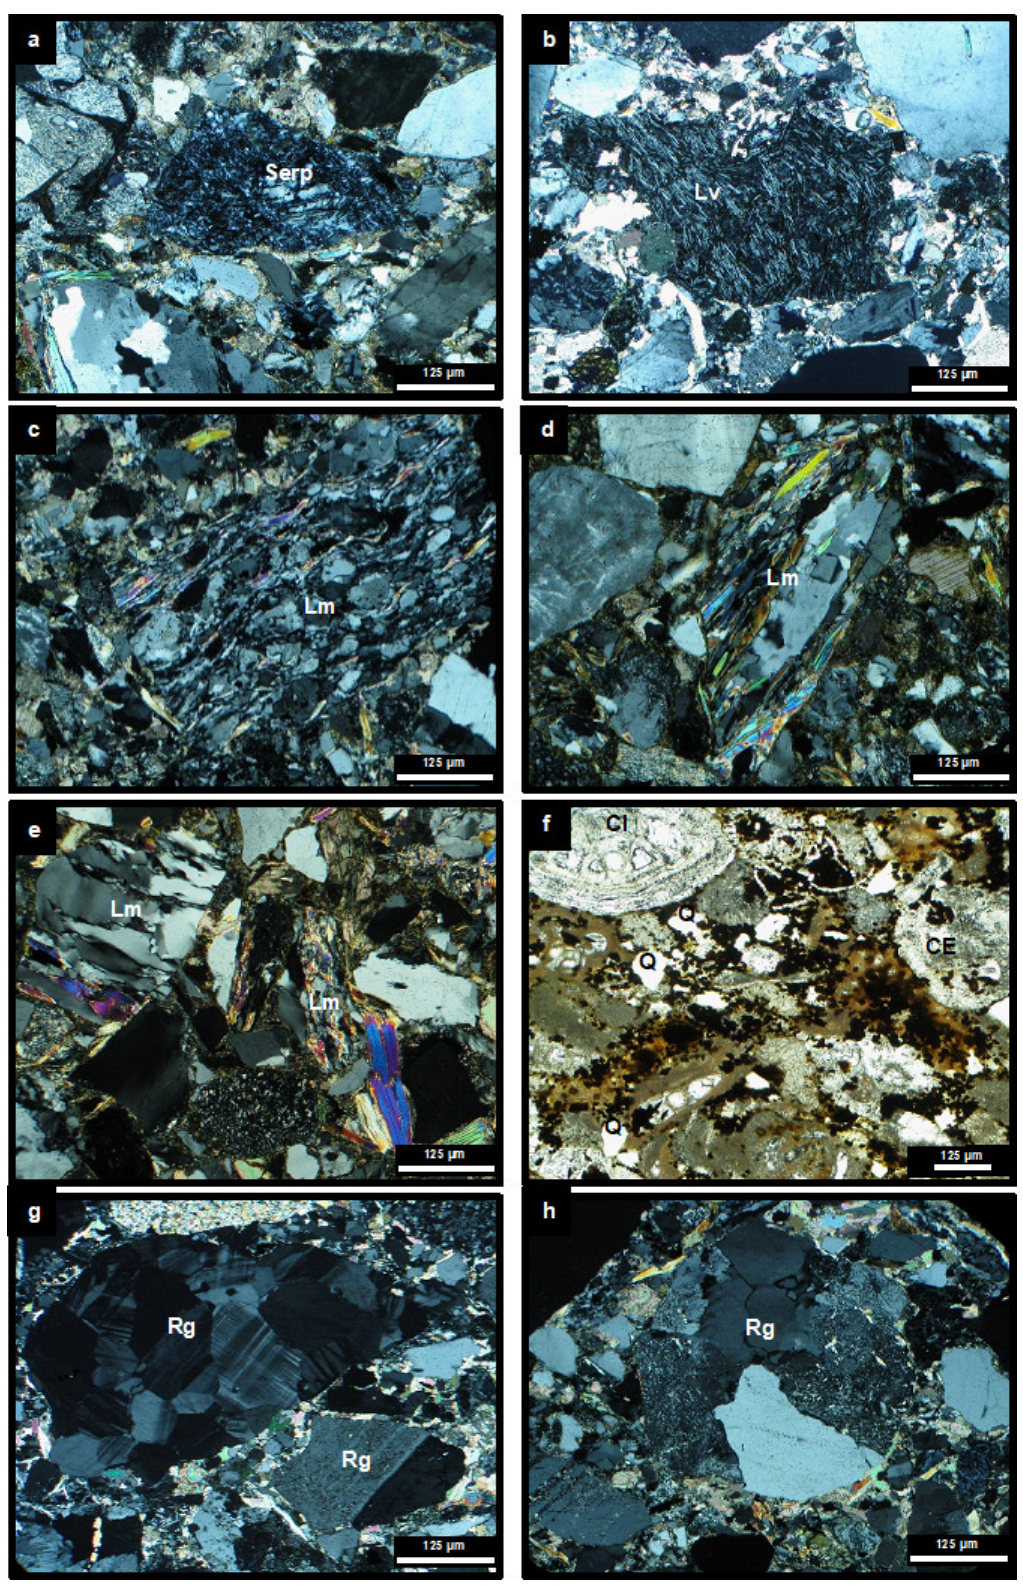
Figure 10. Photomicrographs of the main detrital fragments for quartzolithic, quartz-feldspathic sandstone petrofacies and hybrid arenites of the derived from the borehole stratigraphy of the study area. Quartzolithic petrofacies( a–e ): ( a ) serpentinite having cellular texture; ( b ) volcanic lithic fragments with microlithic texture; ( c ) low-grade metamorphic lithic fragment (Lm; phyllite); ( d , e ) low-to-medium grade metamorphic lithic fragments (Lm, phyllite to micaschist). Hybrid Arenites of the pre-Numidian Sandstone ( f ): ( f ) hybrid arenite having abundant bioclast tests (CI) and quartz (Q),